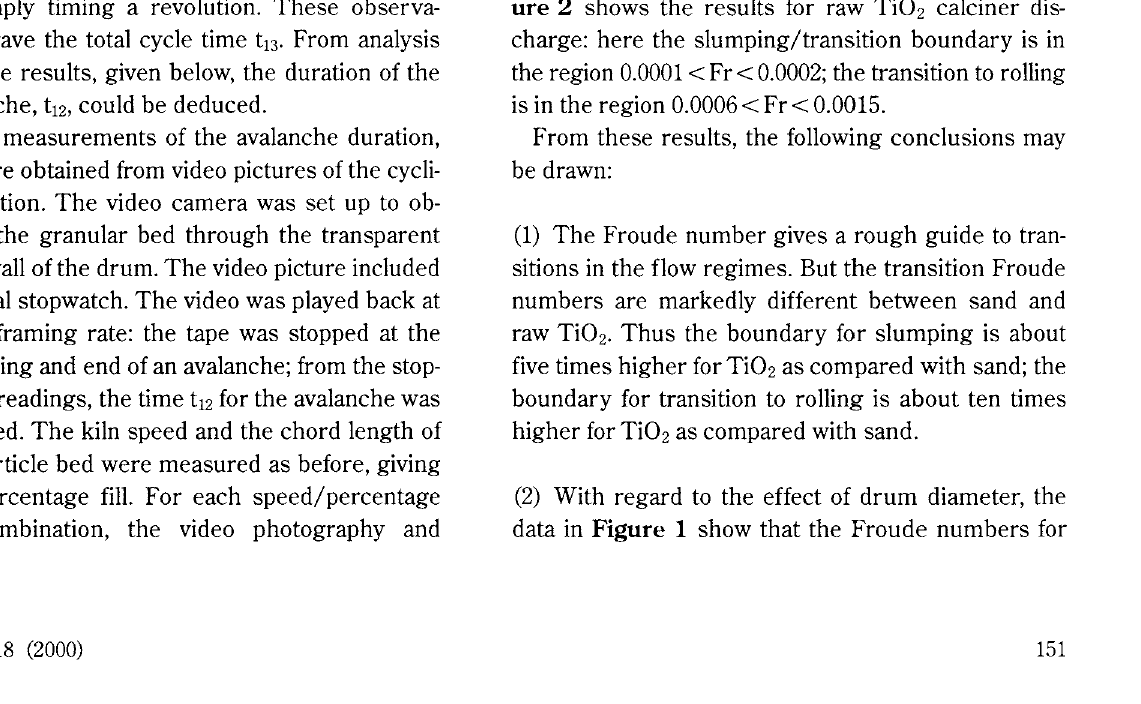
analysis were repeated five times, to give an aver age value of